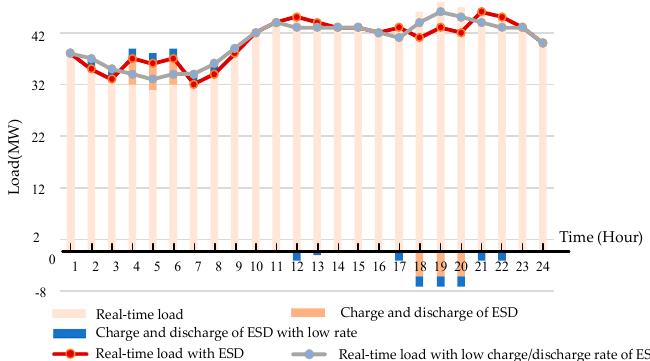
Figure 8. Comparison of load profile of Scheme 4.42 with the original scheme.